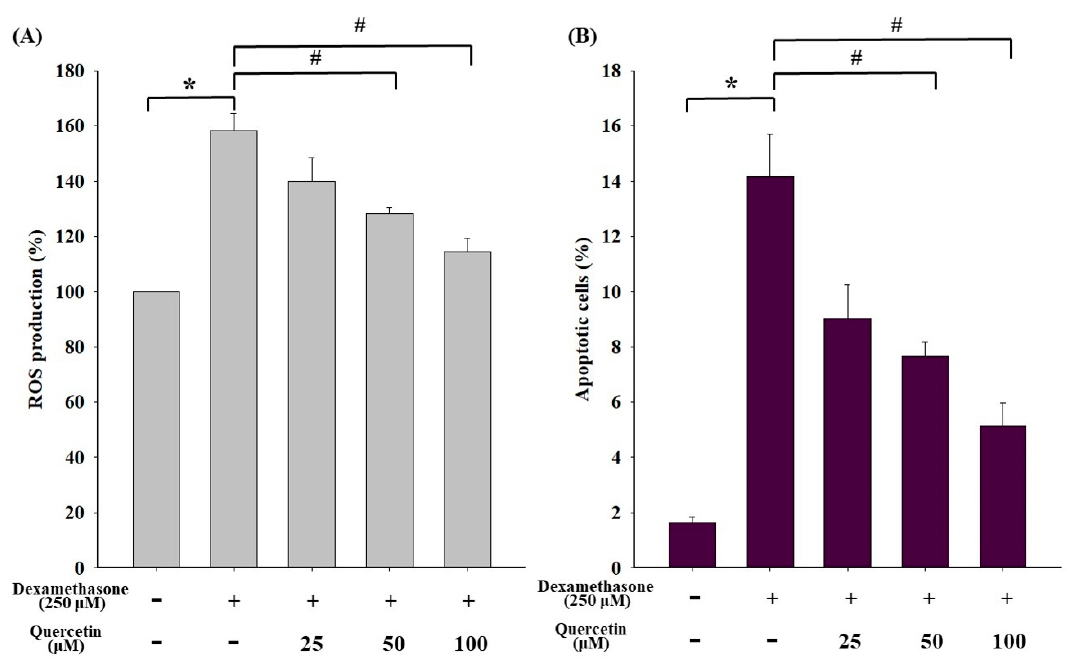
Figure 3. ( A ) Effect of dexamethasone on ROS production in C2C12 myotube cells. Cells were cotreated with 0, 25, 50, and 100 μ M quercetin in the presence of 250 μ M dexamethasone. ( B ) Effect of dexamethasone on apoptosis in C2C12 myotube cells. Cells were cotreated with 0, 25, 50, and 100 μ M quercetin in the presence of 250 μ M dexamethasone. ROS levels were assessed through staining with H2DCFDA, and the loss of ΔΨ m was measured through DiOC(3)6 by flow cytometry. Values represent the mean ± SE (n = 8). Significant differences were determined using Dunnett’s test (* p < 0.05, compared with the untreated group; # p < 0.05, compared with the dexamethasone-treated